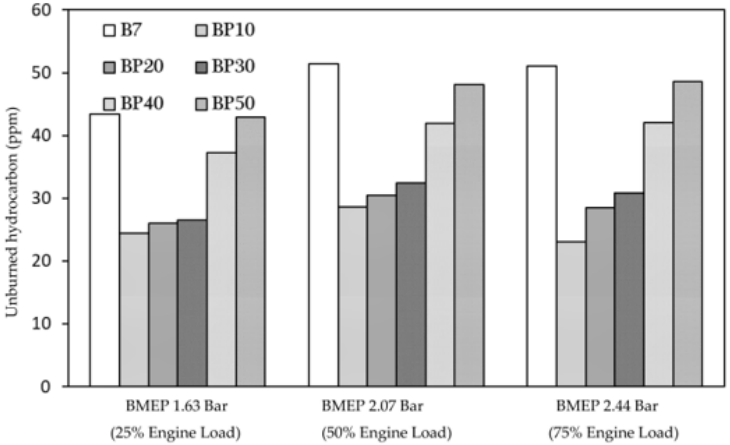
Figure 6. Effects of fuel blends on hydrocarbon emissions